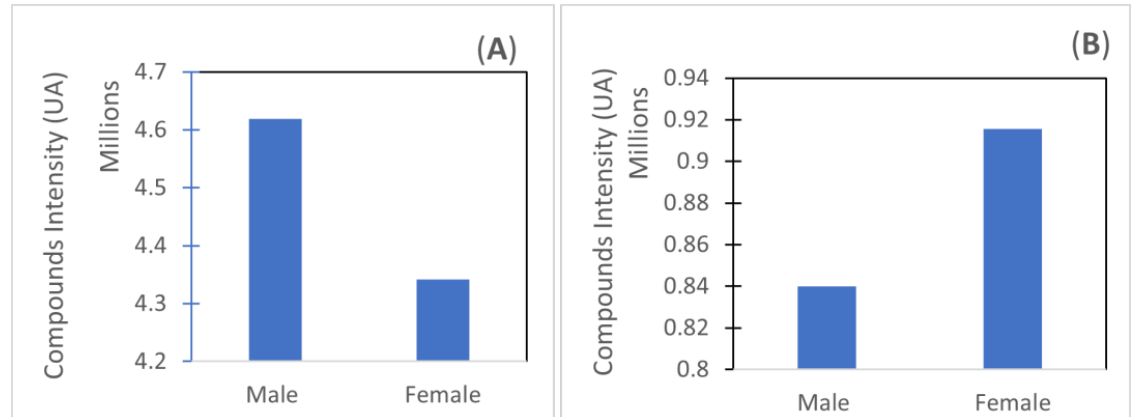
Figure 8. Total compounds intensity for male and female seaweed: ( A ) including citric acid; ( B ) not including citric acid.